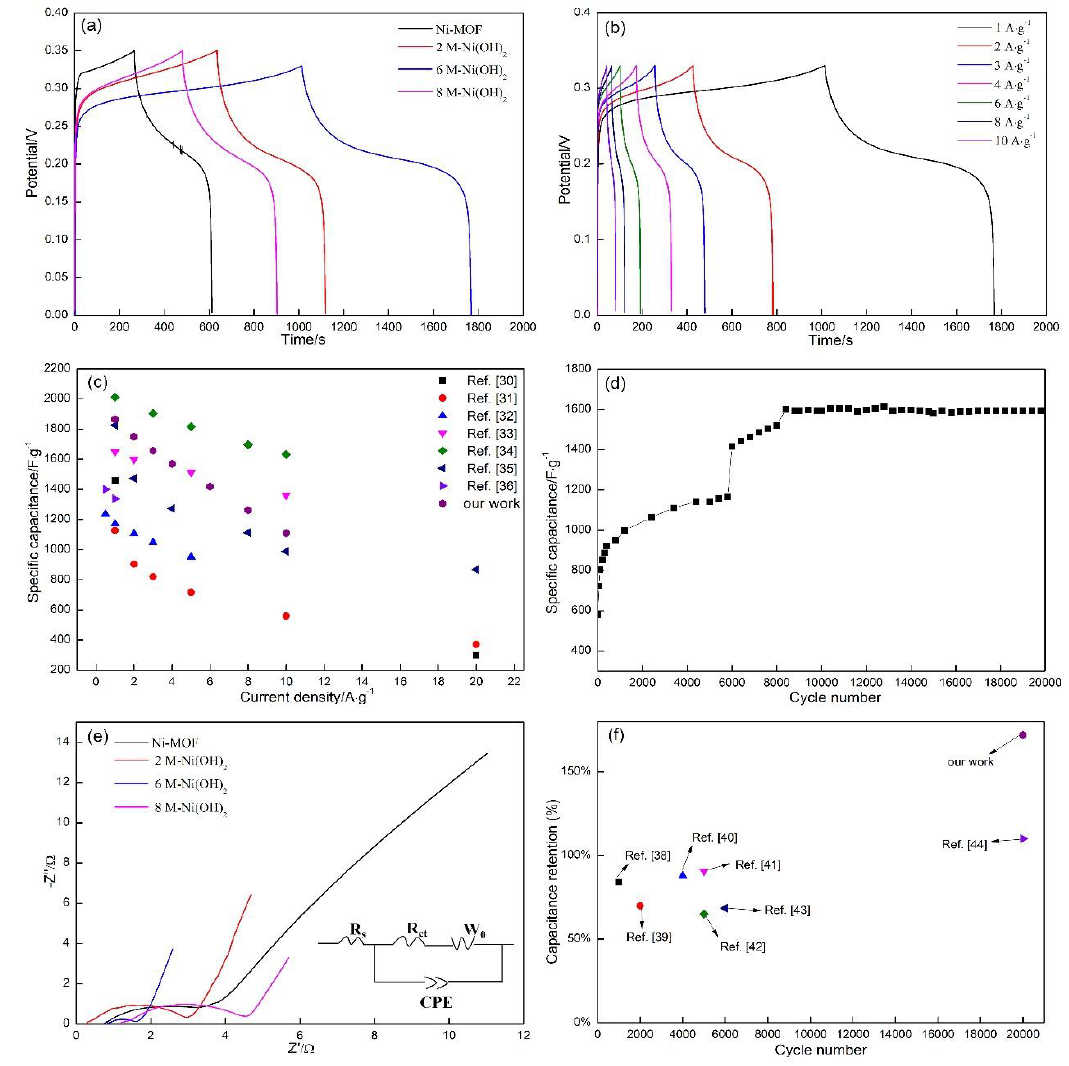
Figure 9. ( a ) Ni-MOF and Ni(OH) 2 at the current density of 1 A·g −1 . ( b ) 6 M-Ni(OH) 2 at different current densities. ( c ) The comparison between the specific capacitance obtained in our work and those reported in other related references. ( d ) Cycling tests for 6 M-Ni(OH) 2 at the scanning rate of 50 mV·s −1 up to 20,000 cycles. ( e ) Nyquist plots of Ni-MOF and Ni(OH) 2 samples. (The inset is the equivalent circuit). ( f ) The comparison between the capacitance retention obtained in our work and those reported.